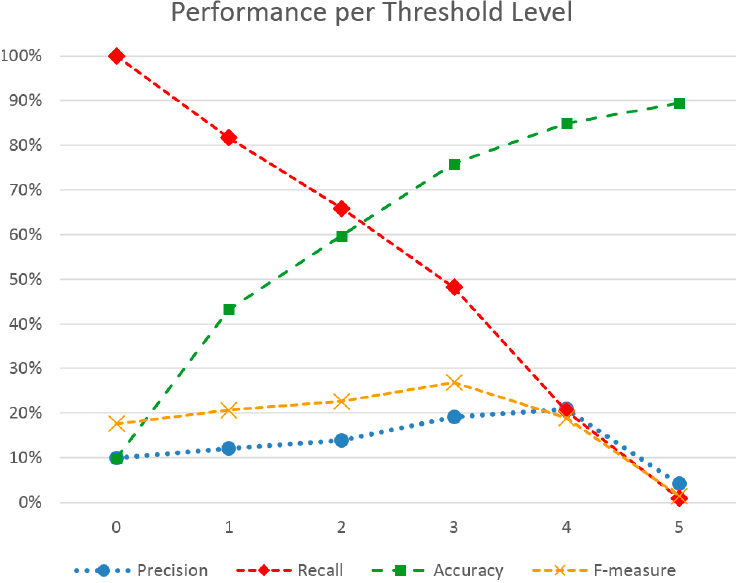
Figure 5. Performance metrics across different stress level thresholds.